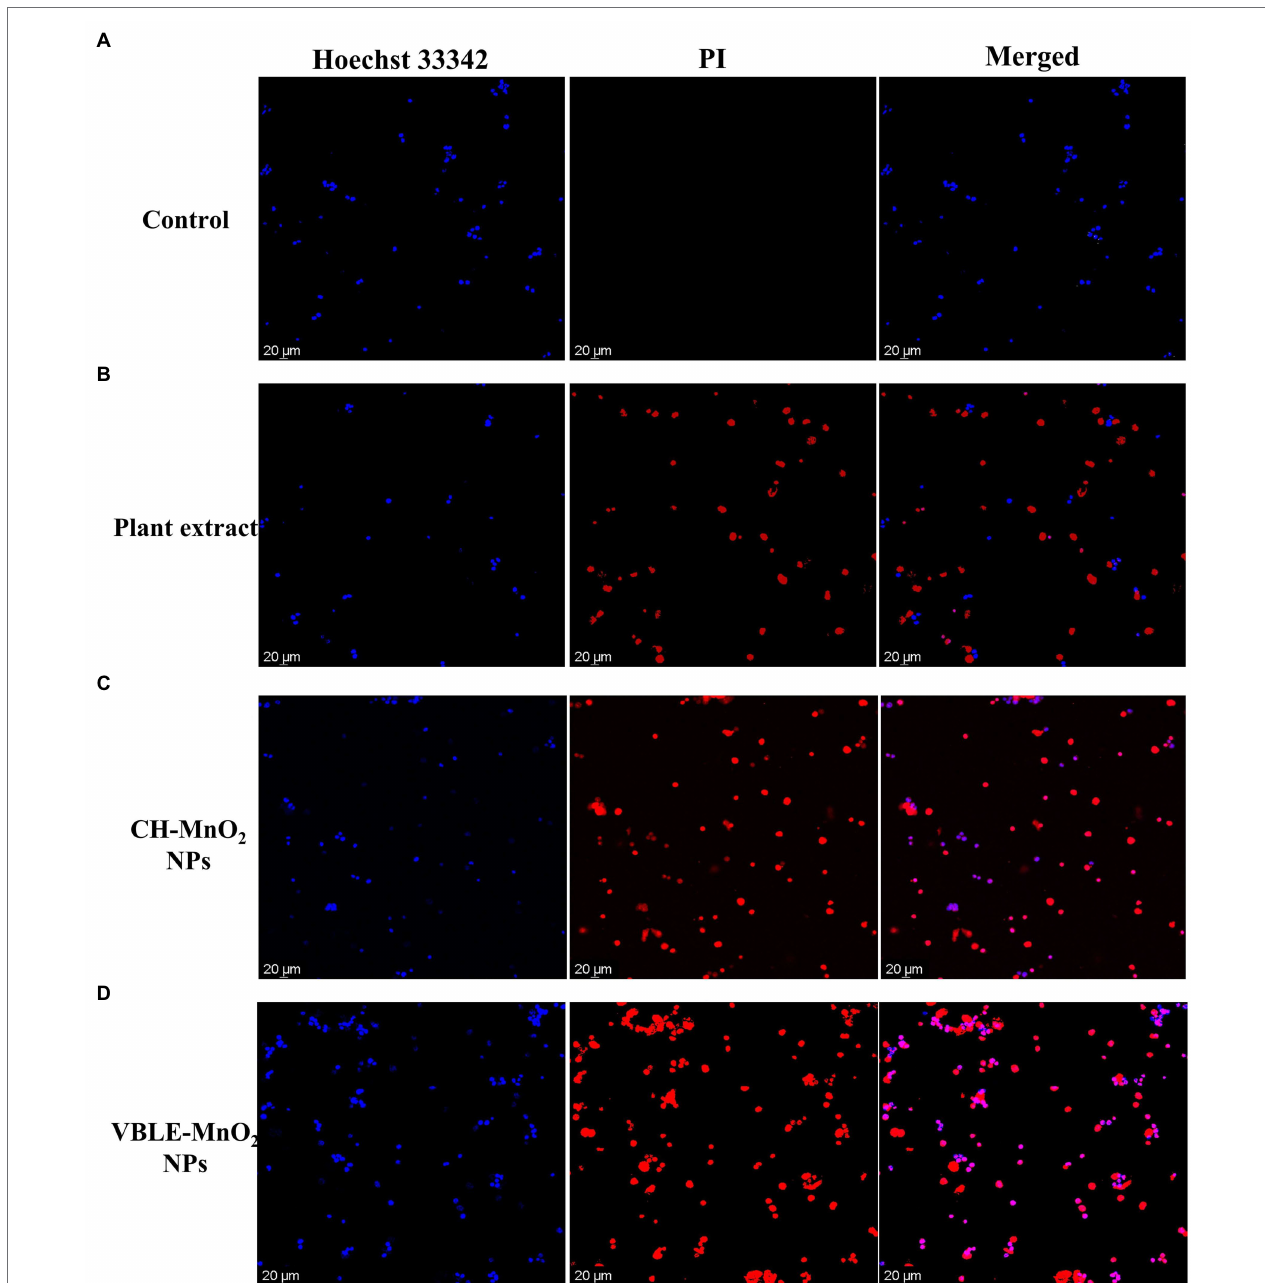
FIGURE 10 | CLSM images of the live and dead MCF-7 cancer cells stained with Hoechst 33342 and PI dye before (A) control and after treatment with (B) plant extract, (C) CH-MnO 2 NPs, and (D) VBLE-MnO 2